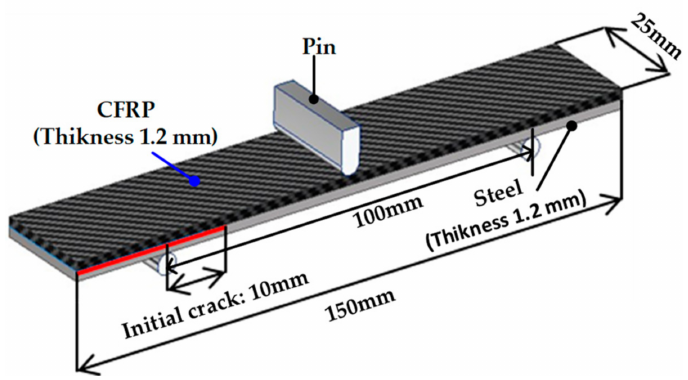
Figure 4. Dimensions of specimen for ENF test.